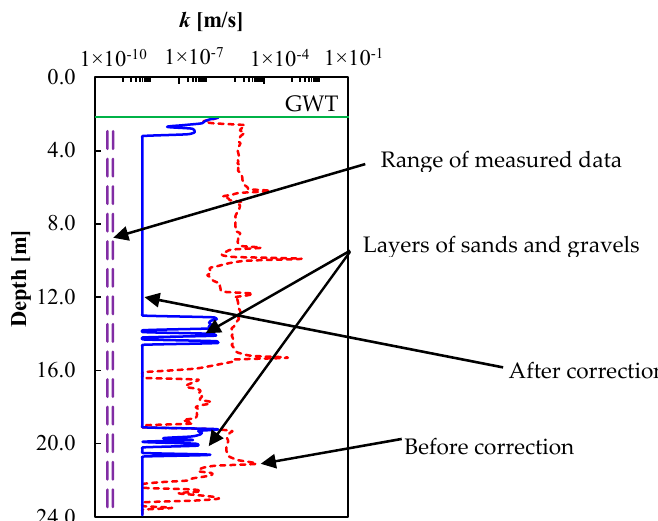
upon Hull [30]. The soil profile at this site is formed by glacial deposition. It is composed